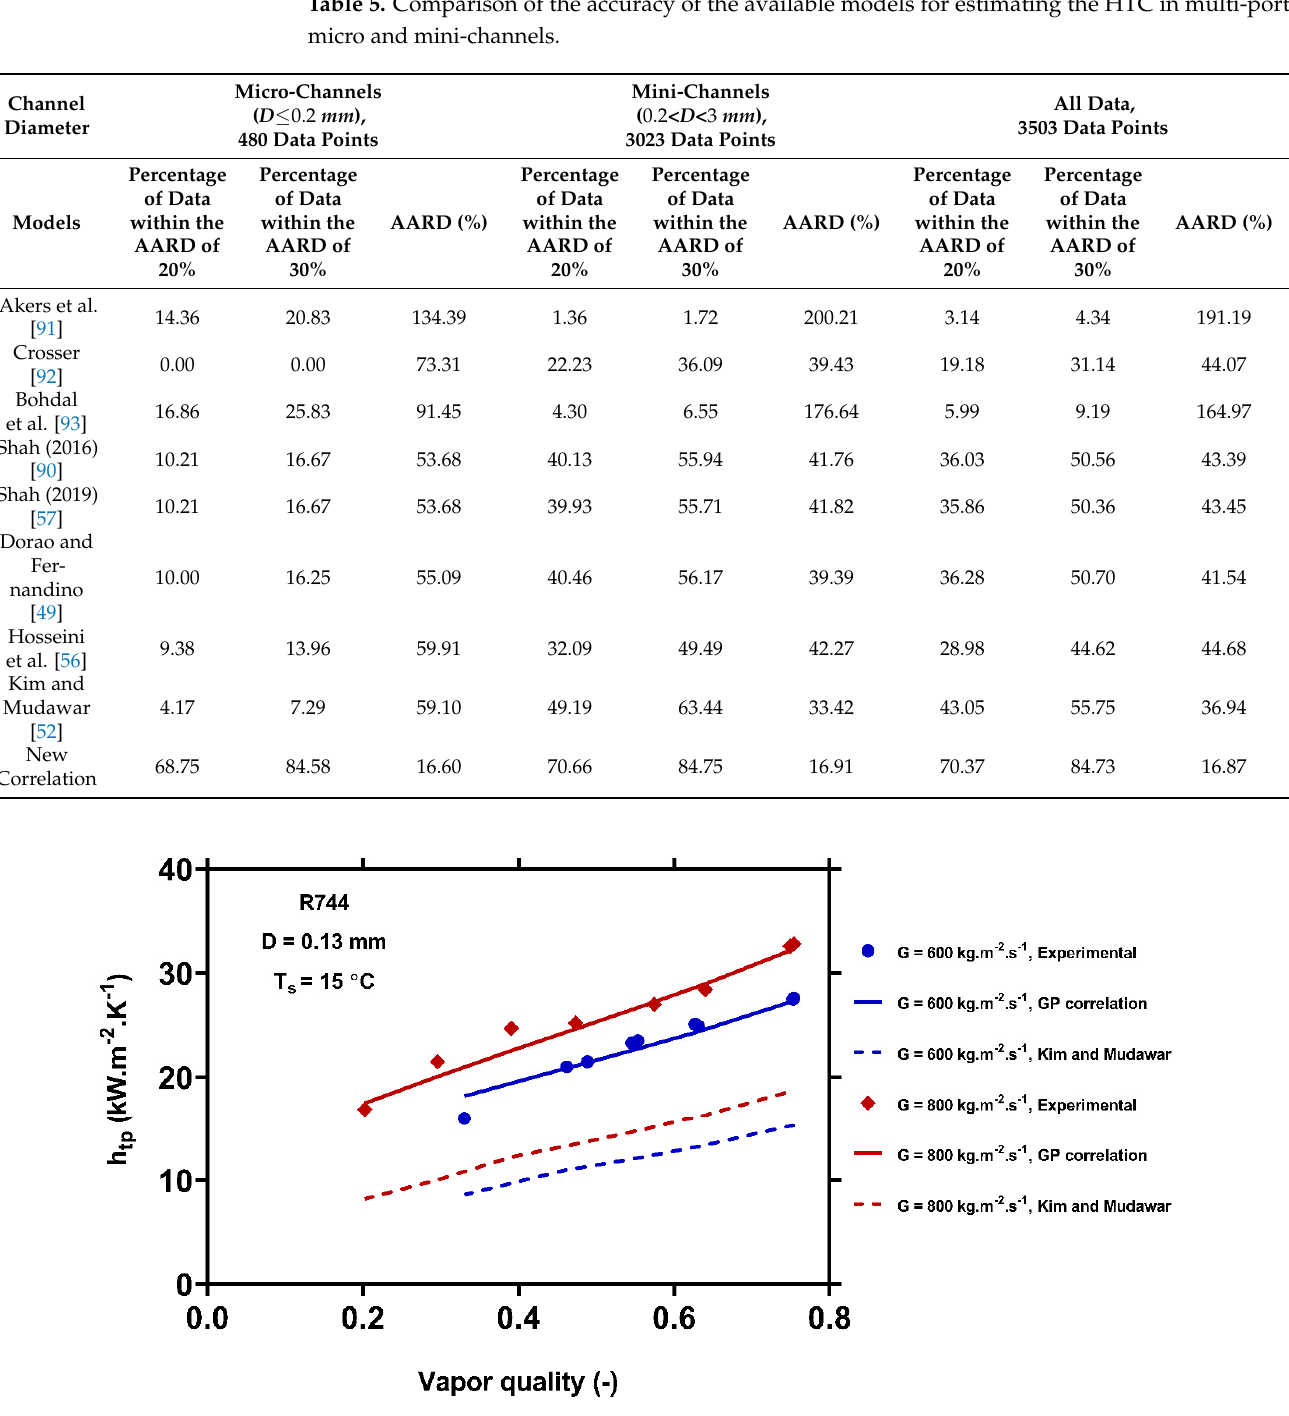
Figure 4. Comparison of the predictions of the GP correlation (Equation (13)) and the model of Kim and Mudawar [52] with the experimental data [37] for R744 condensing at the saturation temperature of 15 °C inside a 0.13 mm channel under different vapor qualities and mass fluxes. Blue and red points represent the G = 600 kg.m − 2 .s − 1 and G = 800 kg.m − 2 .s − 1 , respectively. The solid points, solid lines, and dash lines represent the experimental values, GP outcomes, and Kim and Mudawar [52] outcomes.